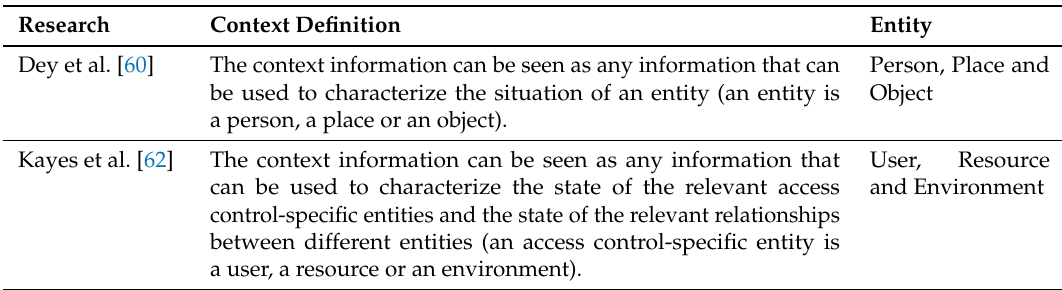
Table 2. Dynamic conditions and contextual